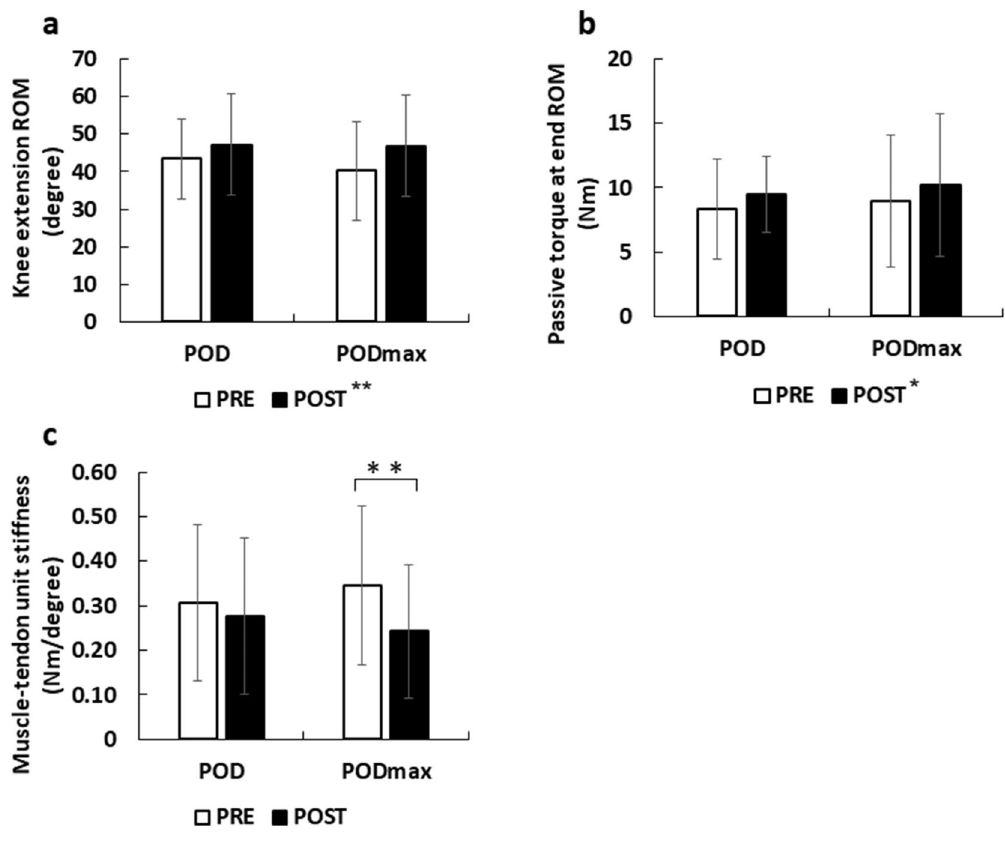
Figure 2. Changes in the knee extension range of motion (ROM) ( a ), passive torque at end ROM ( b ), and muscle–tendon unit stiffness ( c ). Data were represented as mean ± SD. *p < 0.05 (PRE vs. POST). **p < 0.01 (PRE vs. POST).